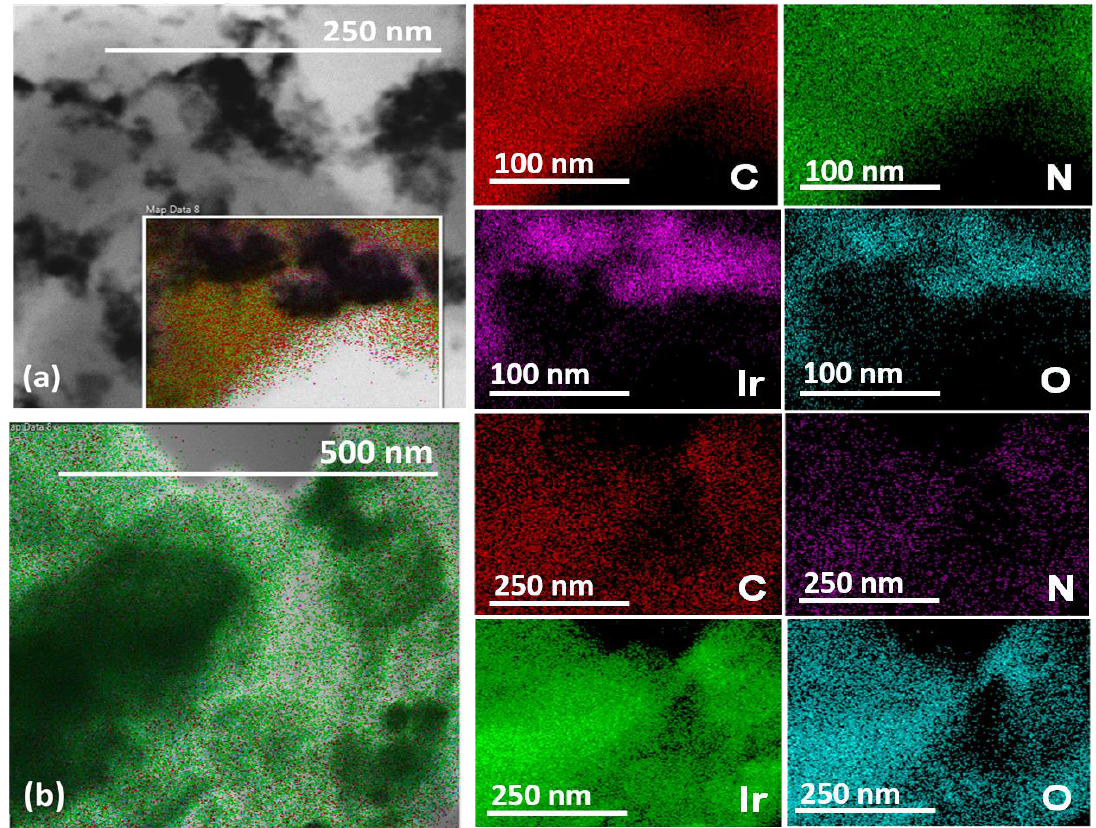
Figure 5. TEM images and corresponding energy-dispersive X-ray spectroscopy (EDX) mapping for ( a ) gCNH-IrO 2 (40%) prepared by the ball-milling of pre-prepared IrO 2 and gCNH materials; ( b ) gCNH-IrO 2 (20%) prepared by in situ deposition of IrO 2 on gCNH support following an adaptation of Adams’ fusion method at 450 °C.